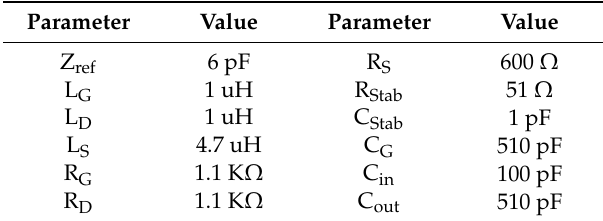
Figure 3. A schematic of the proposed non-Foster circuit. Table 1. Optimized values of passive components in Figure 3.